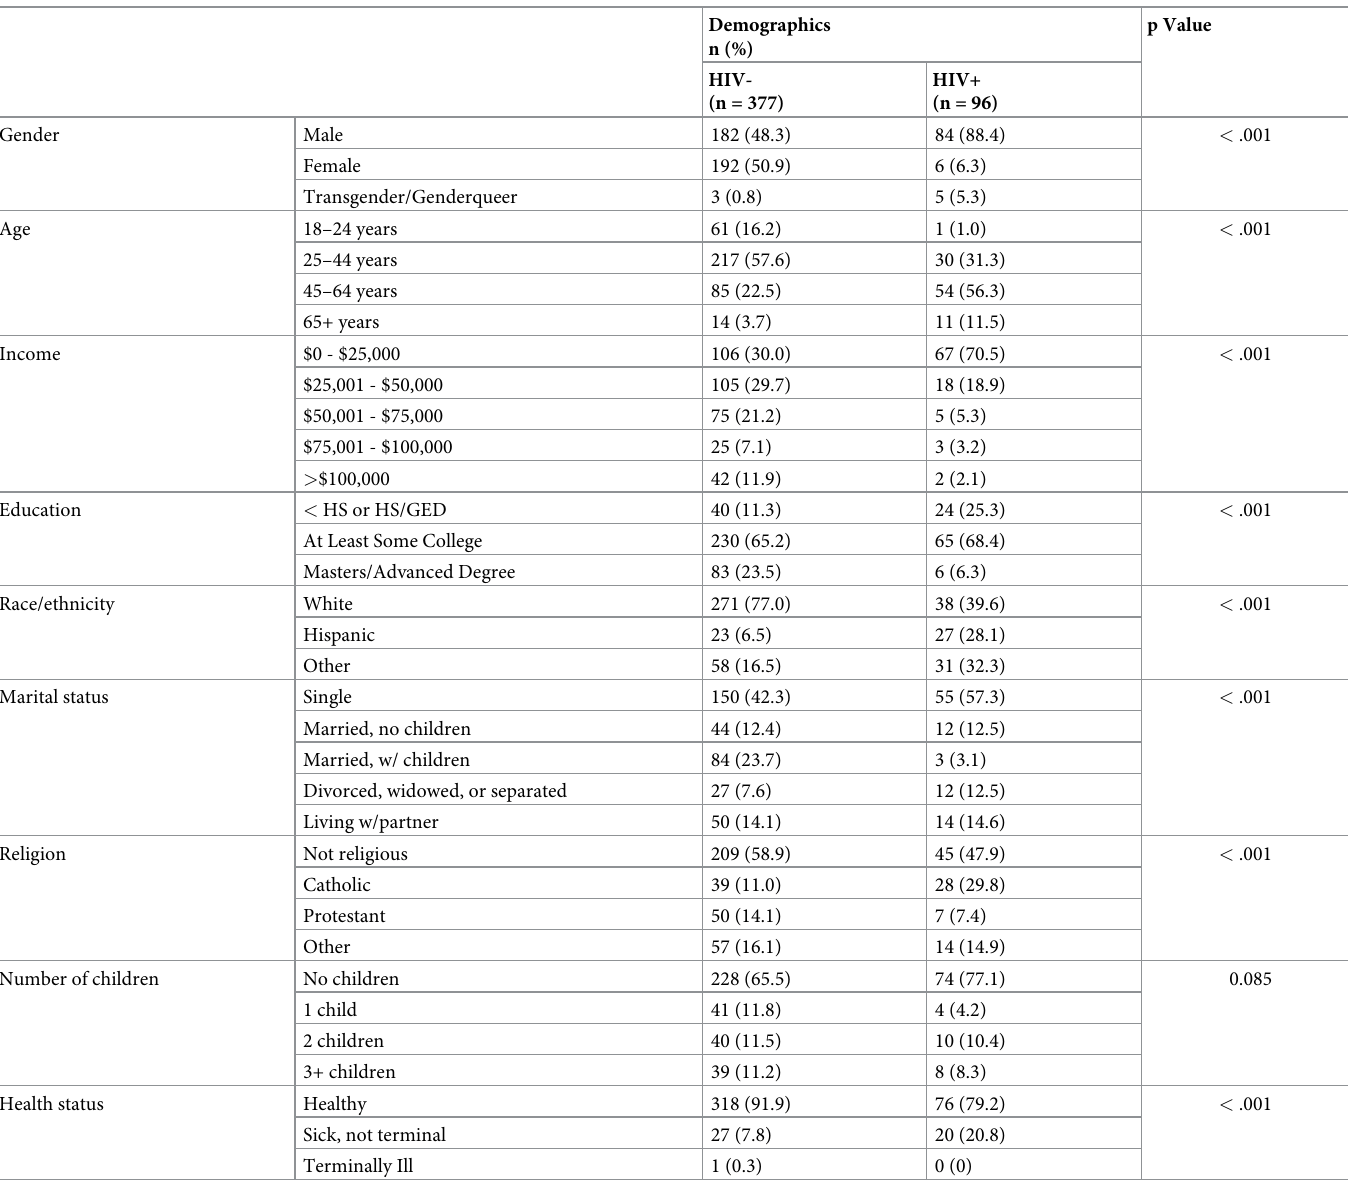
Table 1. Characteristics of HIV negative and positive